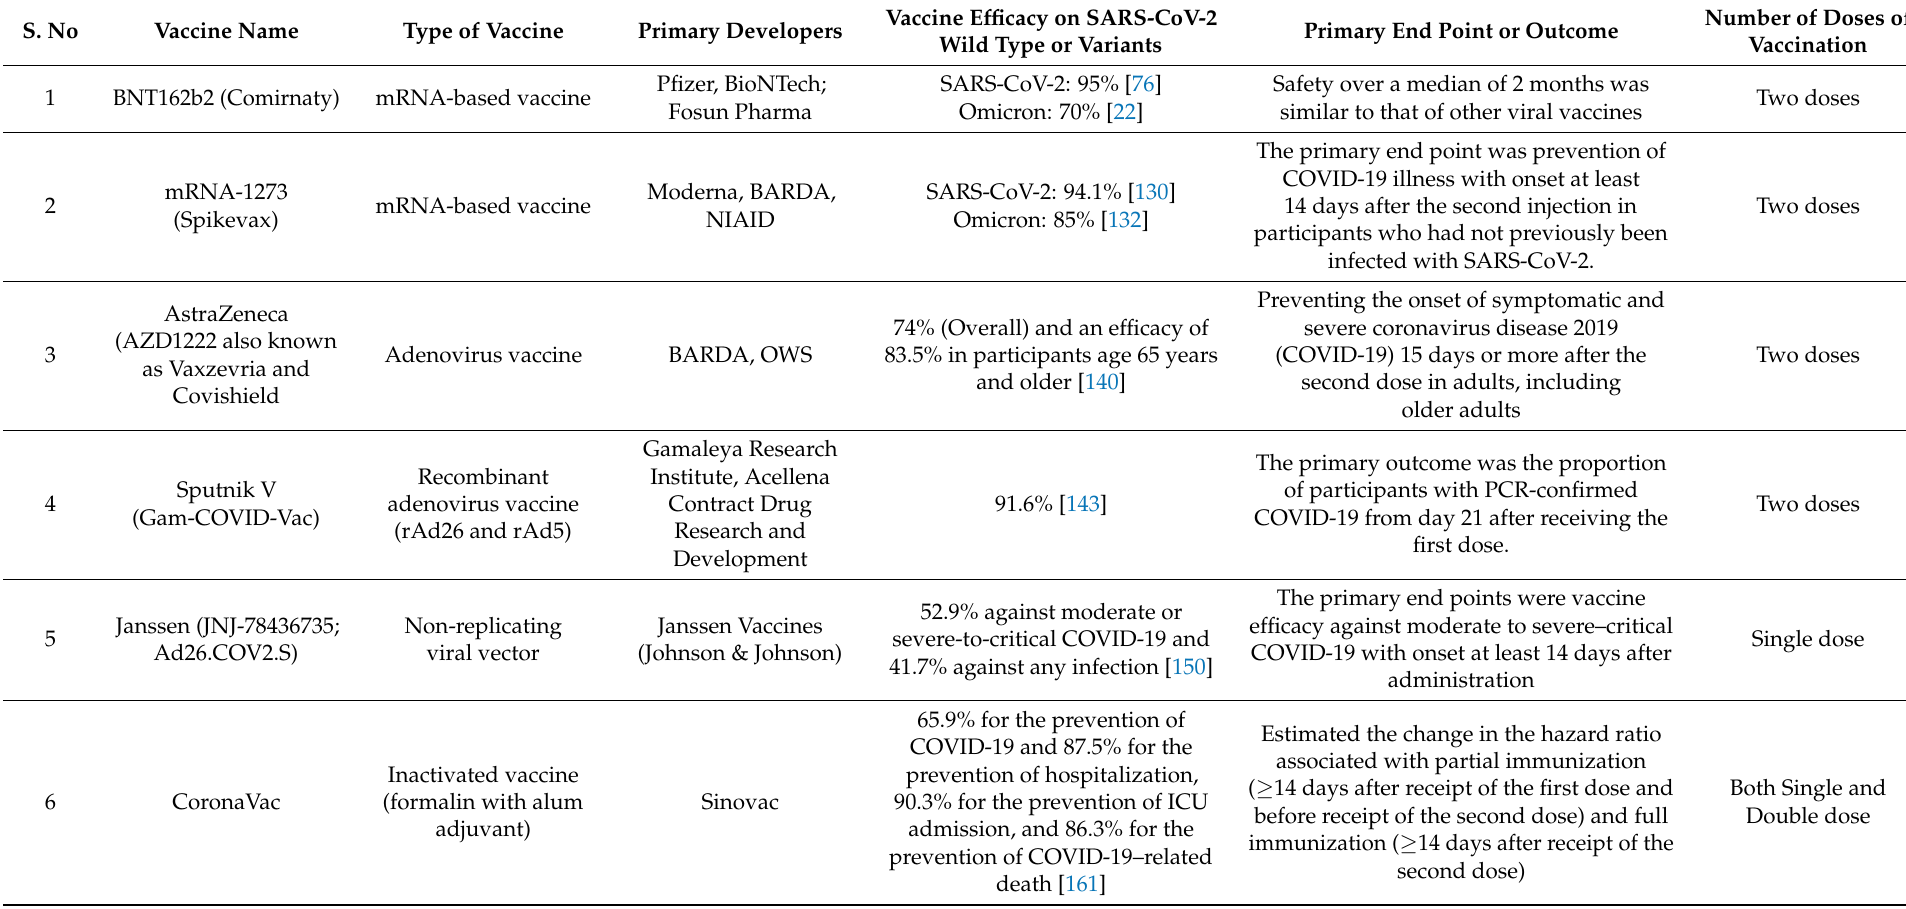
Table 6. List of vaccines authorized for combating the SARS CoV-2 and their reported